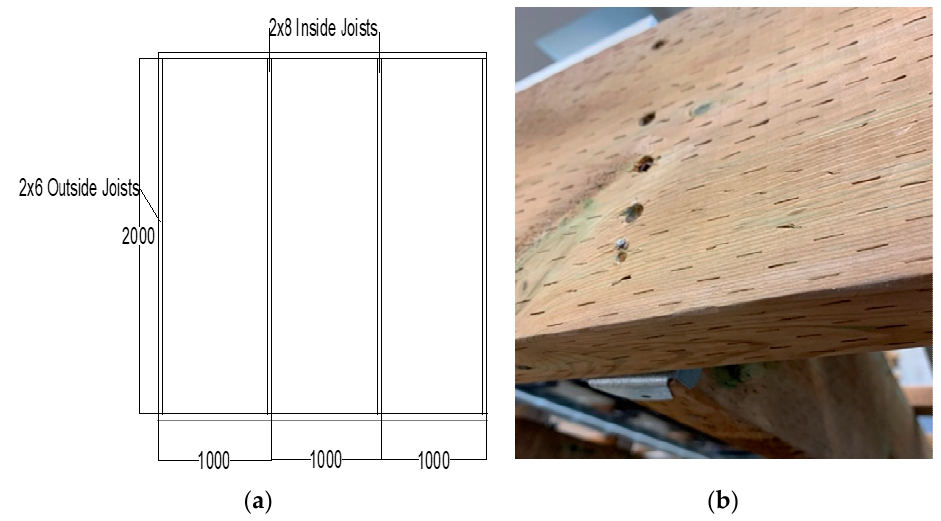
Figure 3. ( a ) Frame composition consisting of two 2 × 8 outside joists, two 2 × 8 inside joists, and two 2 × 8 beams, and ( b ) each joist connected with fence brackets, 1-1/2 ″ joist hanger nails, and 3 ″ brown deck screws.